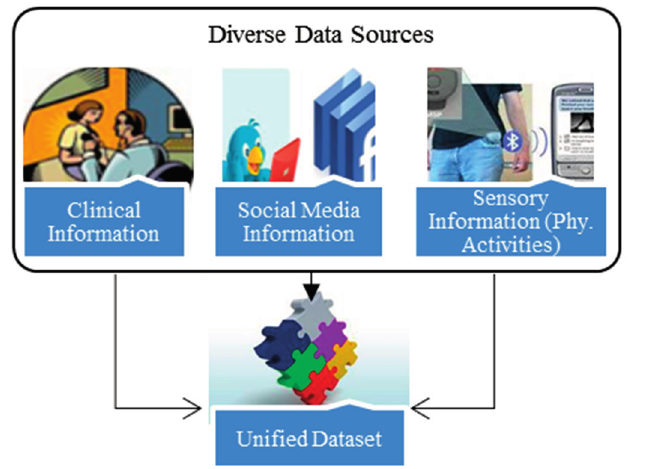
Figure 1. Scenario to integrate diverse datasets into a unified